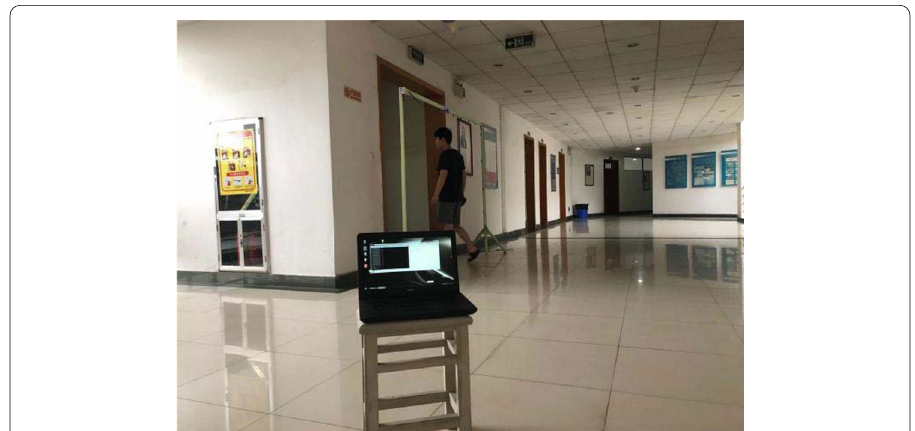
Fig. 8 The experimental scene (A):indoor